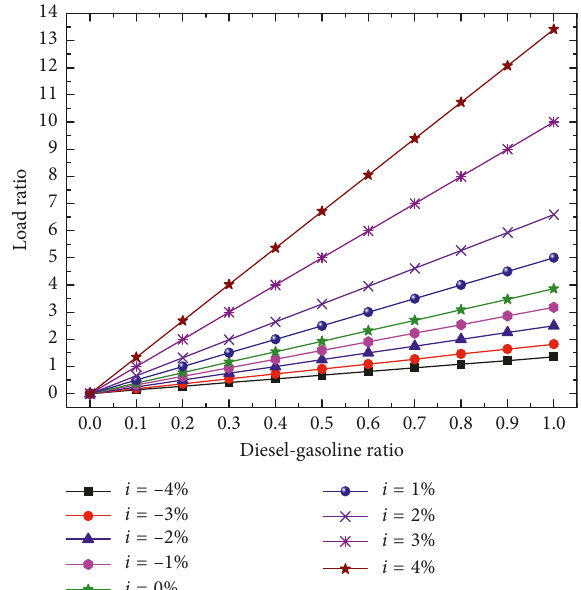
Figure 4: Load ratios changing with slope percentage (40km/h, idling condition).